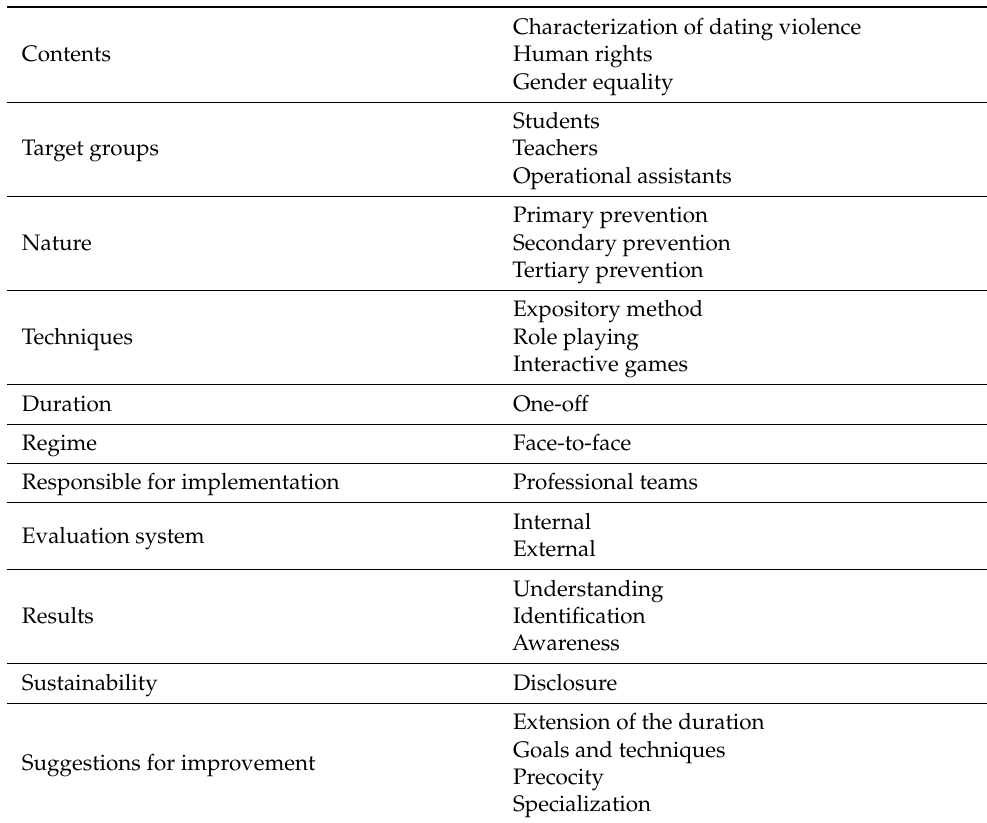
Table 1. Characterization of dating violence prevention